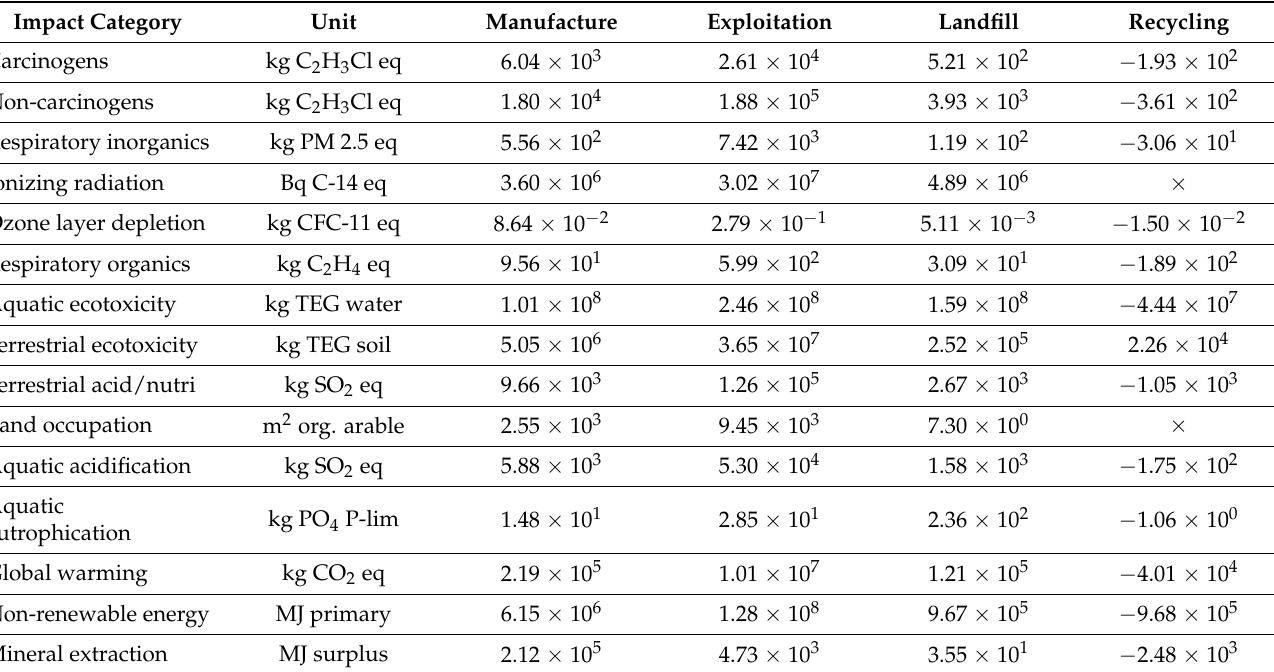
Table 3. The results of characterizing the environmental consequences occurring at individual stages of the life cycle of the research object.